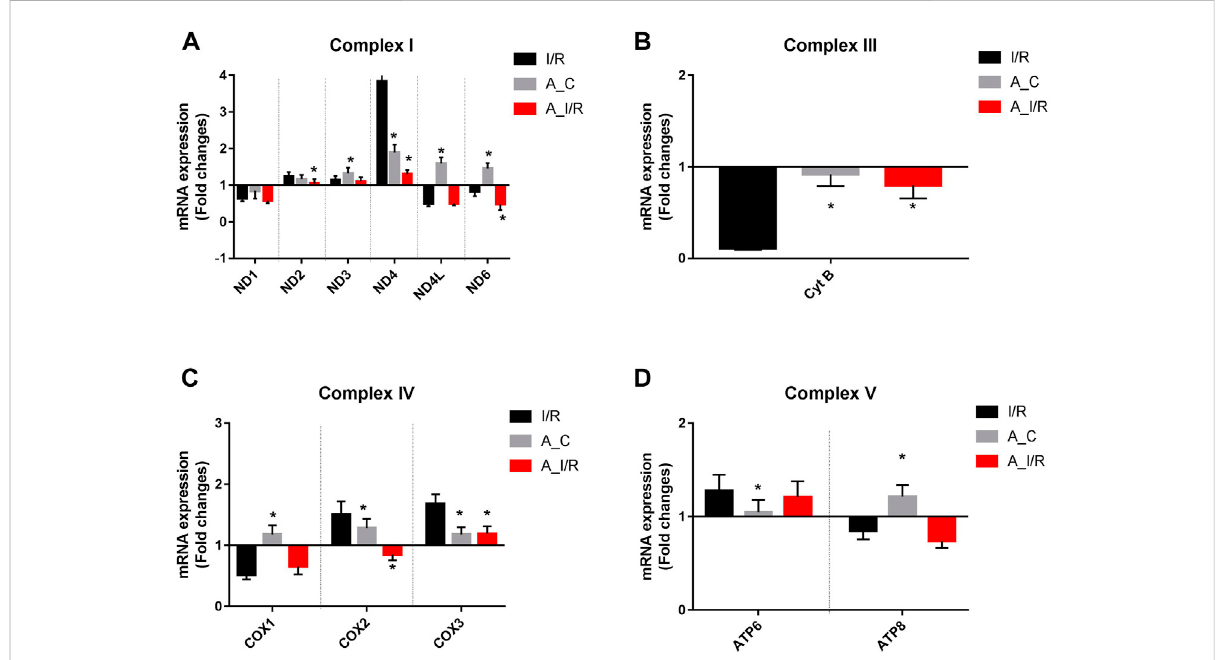
FIGURE 3 Differential expression of mitochondrial encoded ETC genes in young and adult hearts during I/R: The mRNA expression of the ETC genes encodedbymitochondrialarepresentedfor (A) ComplexI; (B) ComplexIII; (C) ComplexIV; (D) ComplexV.Thevaluesareexpressedasfoldchanges from normal. The graphs represent mean ± SD values. *p < 0.05 vs. I/R .